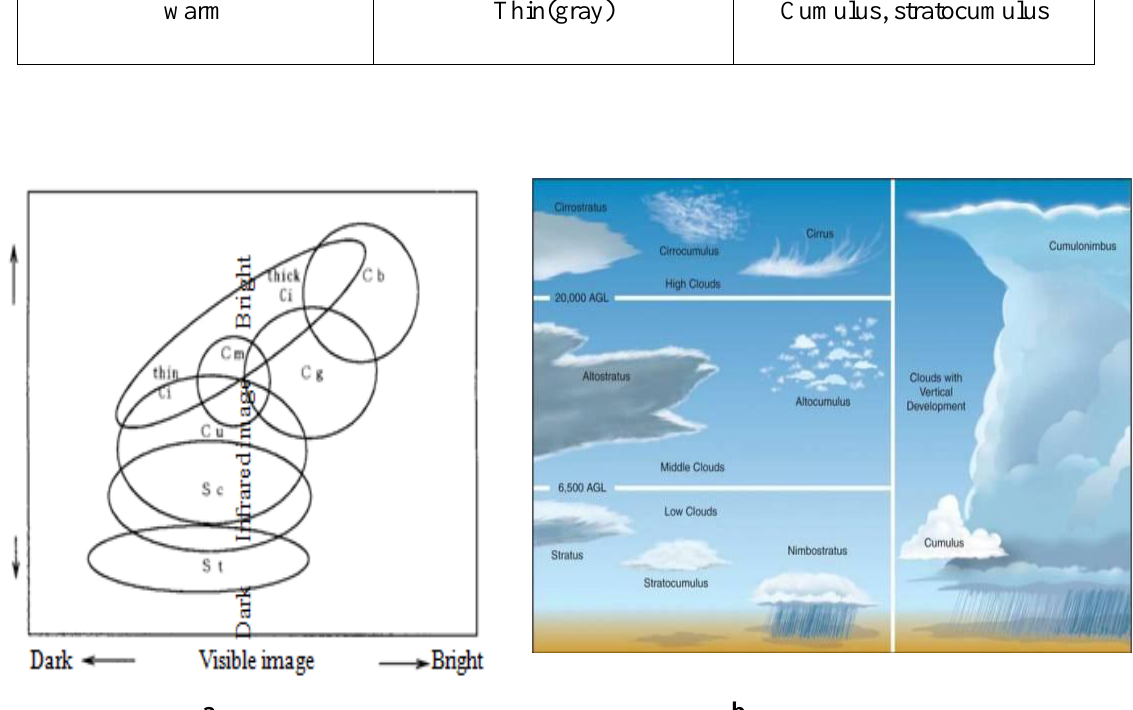
Fig. 9: a) Represent the brightness and darkness of clouds that appears in visible and infrared satellite images. b) represent which clouds are rainy